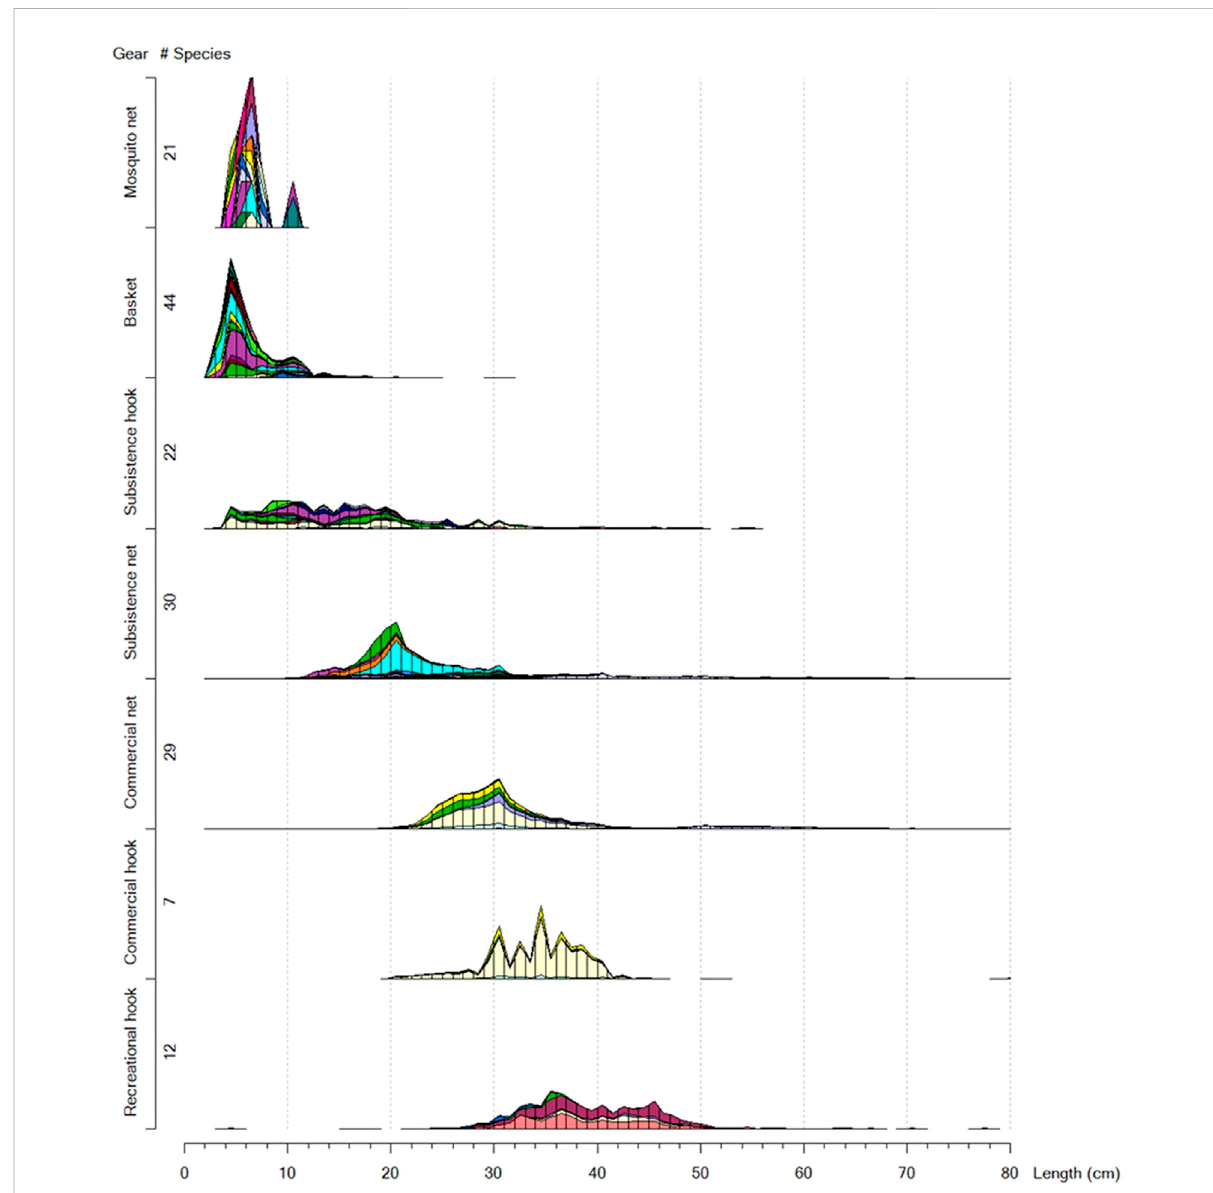
FIGURE 3 Gear signatures in terms of species and size selectivity of the seven most frequently encountered fi shing methods in the Okavango Delta. The order of the species is according to the maximum lengths encountered in the catch. Each gear has its own speci fi c signature and there is a clear overall difference in sizes and partly targeted species between the commercial/recreational fi shery, targeting larger species and sizes, and the subsistence fi shery, targeting smaller species and sizes (Source: Mosepele,